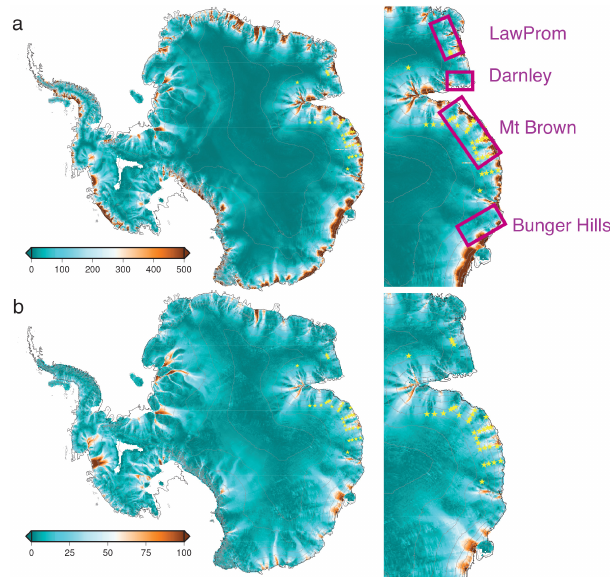
Figure 3. Elevation change (metres; (a) ) and ice advection (kilo- metres; (b) ) over 1000 years, calculated using a modified version of the Lagrangian streamline tracing of Roberts et al. (2011), with ice velocities from the MEaSUREs data set (Rignot et al., 2011). Blue areas show comparatively little elevation change and/or advection over 1000 years. The right-hand panels are the enlarged coastal East Antarctic section of each panel. Stars indicate historical ice core lo- cations for short